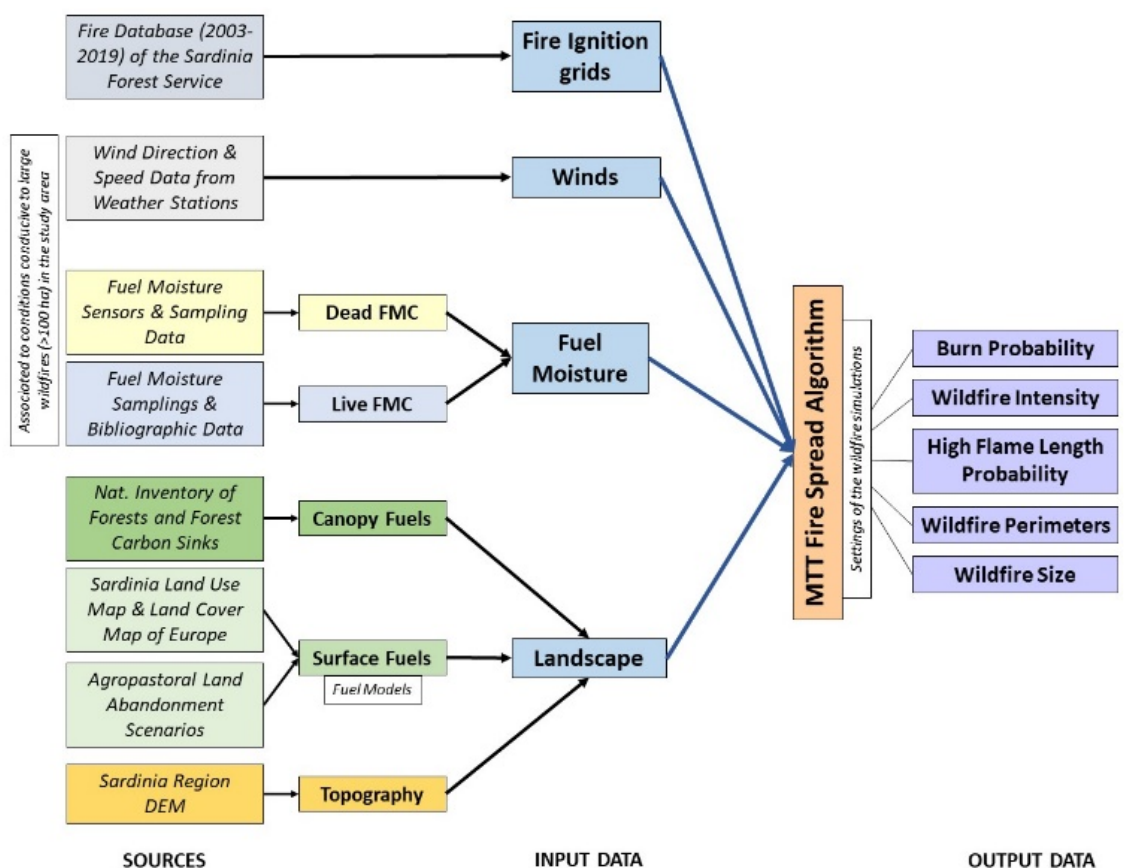
Figure 2. Summary flowchart of the input and output data used for performing this study. More details can be found in the Methods. Table 1. Fuel model data was used for the wildfire simulations. A different combination of fuel models was used depending on the bio ‐ climatic conditions of the study area, as described in the Methods. CH = canopy height; CBD = canopy bulk density; CBH = canopy base height. LMM = lower mesomediterranean; UMM = upper mesomediterranean. Fuel Type